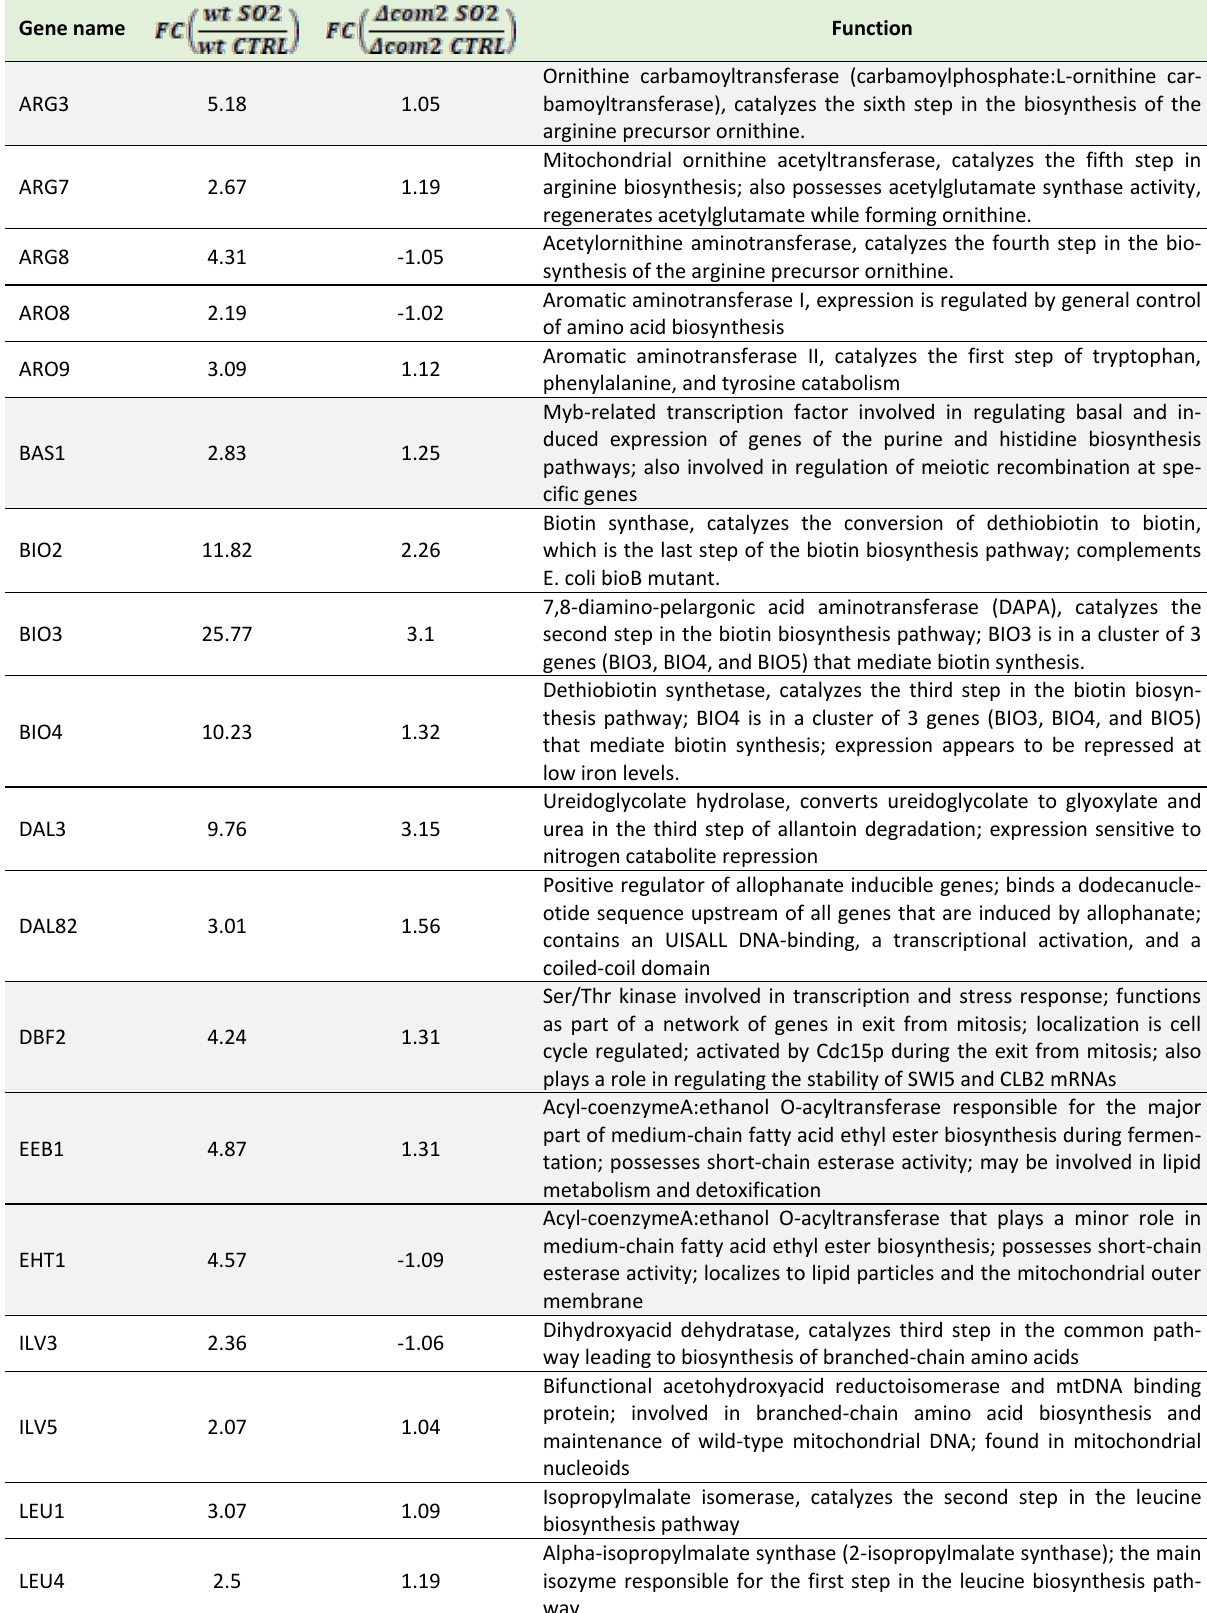
TABLE 1. List of genes whose SO2-induced transcriptional activation registered in S. cerevisiae BY4741 cells is abolished in the absence of COM2. Genes whose elimination leads to an increase in yeast susceptibility to SO2 are highlighted in gray. Gene